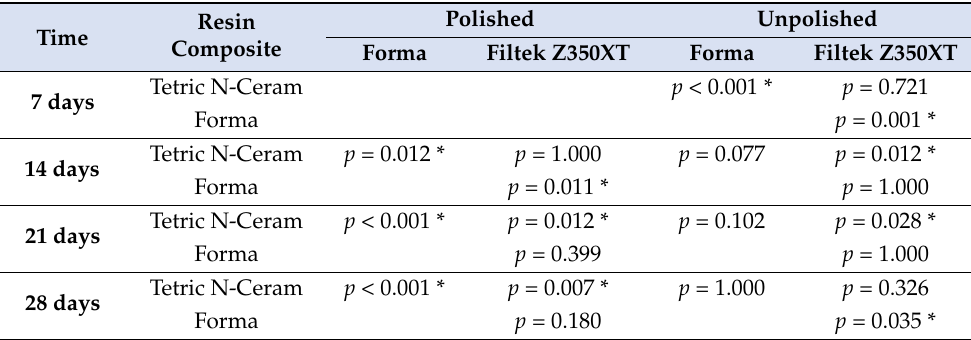
Table 4. Multiple comparison of color variations ( ∆ E) between polished and unpolished resin composites as a function of time. Polished Unpolished Resin Time Composite Forma Filtek